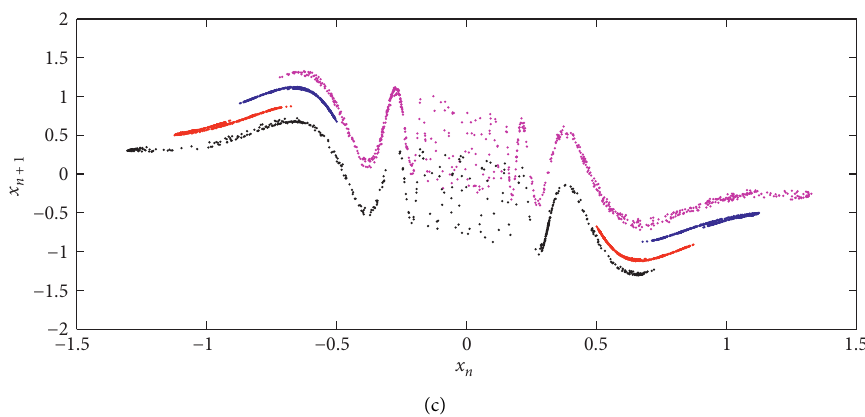
Figure 8: The coexisting attractors of the fractional-order map (8) with parameters A � 0 . 5 , B � 0 , C � 3 and with the initial condition x � − 0 . 1 for the red attractor and x � 0 . 1 for the blue attractor; (a) chaotic attractor for μ � 0 . 9, (b) three coexisting chaotic attractors for 0 0 � 10 for the magenta attractor; (c) four coexisting chaotic attractors for μ � 0 . 3 with initial condition μ � 0 . 6 with initial condition x 0 � 10 for the magenta attractor and x � − 10 for the black attractor. x 0 0